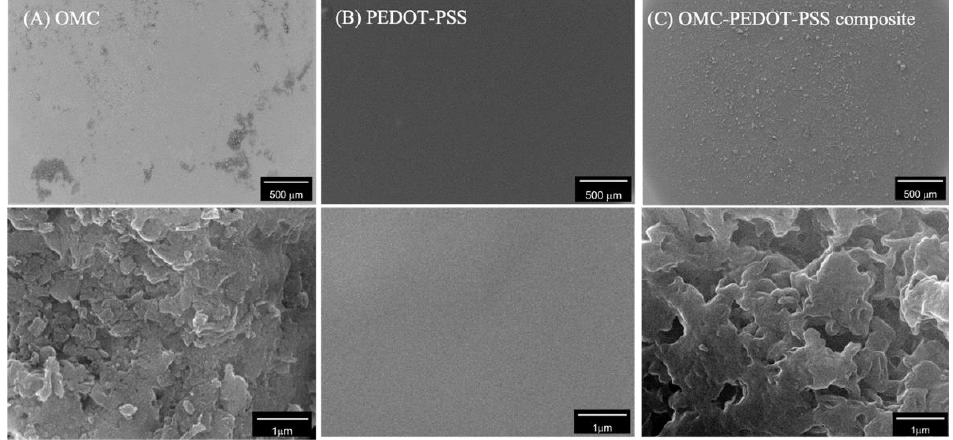
Figure 2. SEM images showing the morphologies of the surface modified with ( A ) OMC ( B ) PEDOT - PSS and ( C ) the composite of OMC and PEDOT - PSS.